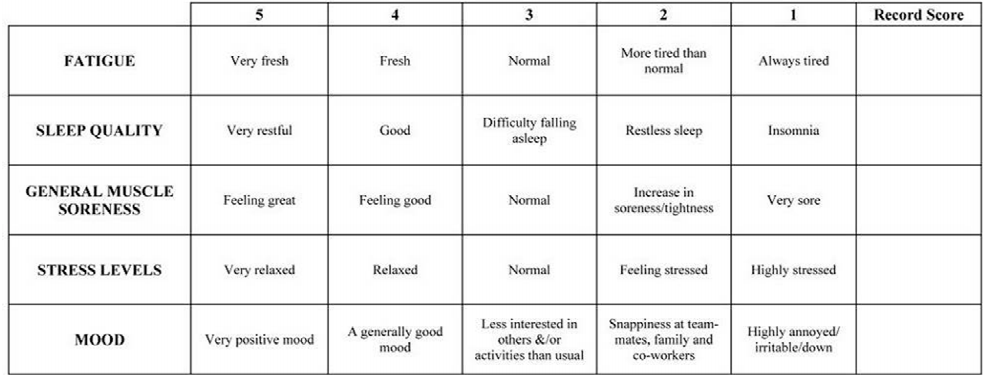
Figure A1. The Fatigue and Well-Being Assessment pattern.